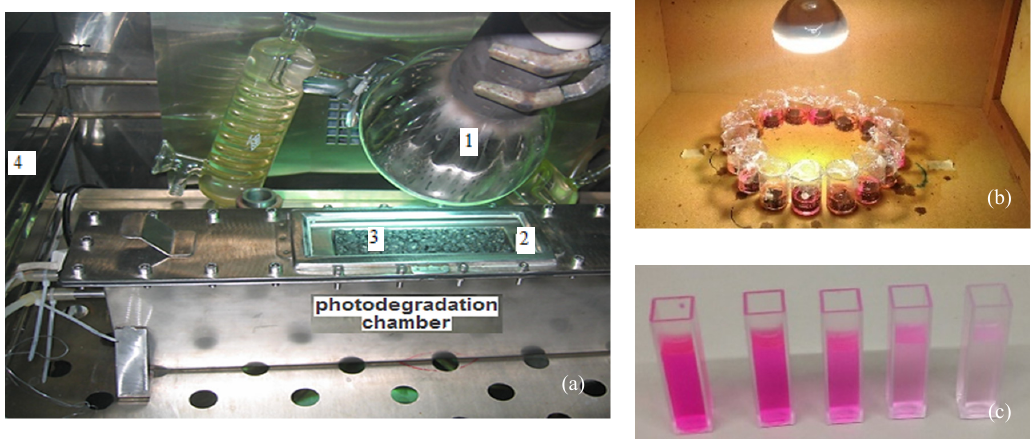
Figure 4. Experimental tests to measure the photocatalytic activity: ( a ) NO x degradation efficiency (1: lamp for light irradiation, 2: quartz window, 3: test specimen, and 4: temperature stabilizer); ( b ) degradation of an organic dye; ( c ) aqueous solution of an organic dye of different color intensity over time, thus indicating its degradation.